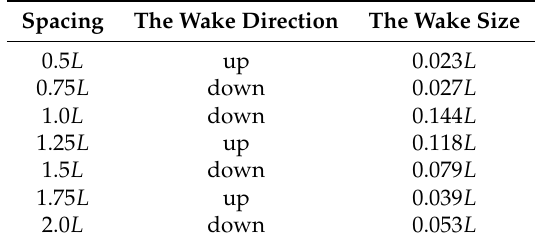
Figure 11. The wake of the tandem swarm: ( a ) the size and location of the wake; at the spacing of 1.0 L : ( b ) the fish head swings downwards, ( c ) the fish head swings upwards; at the spacing of 1.25 L : ( d ) the fish head swings downwards, ( e ) the fish head swings upwards. Table 4. The wake directions and sizes near the head of no.2